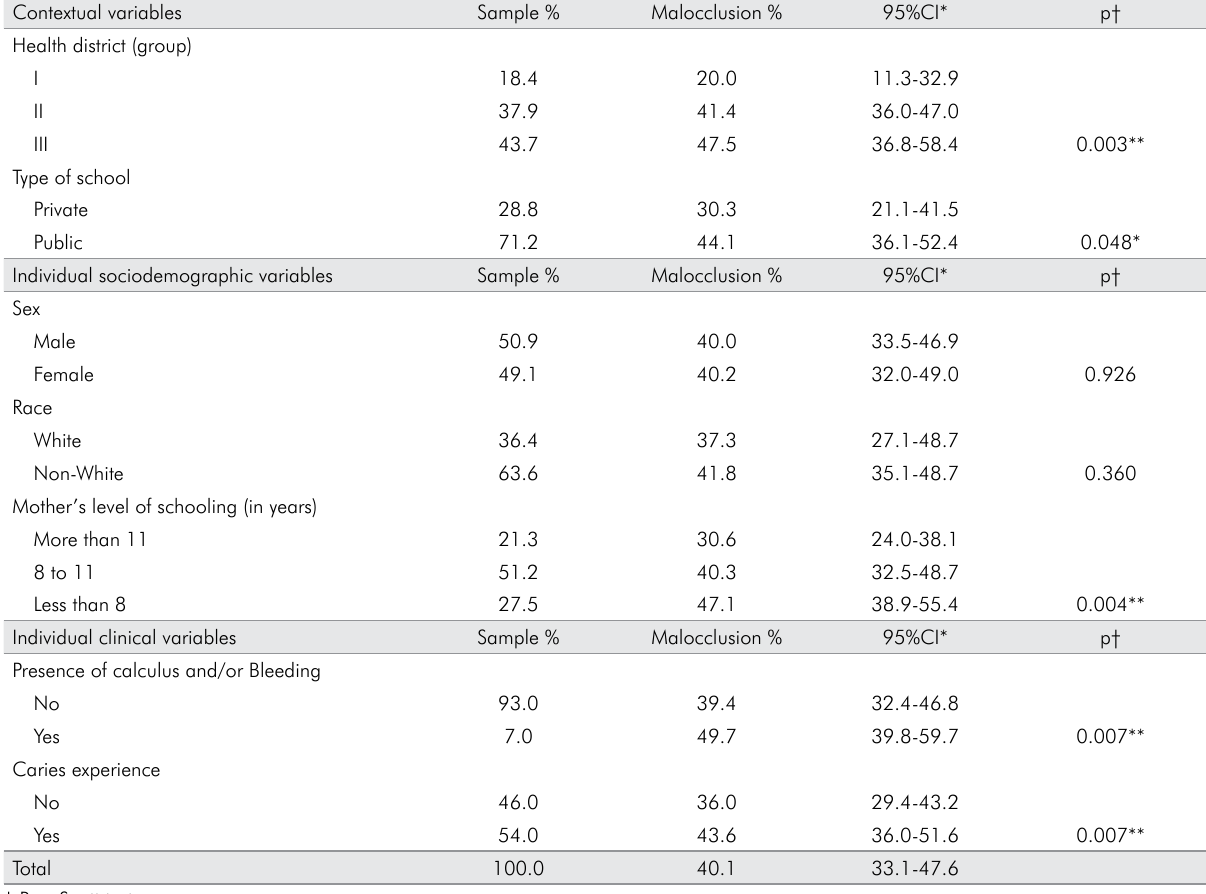
Table 1. Prevalence of malocclusion and confidence intervals (95%CI) according to independent variables. 12-year-old schoolchildren, Goiânia, Brazil,